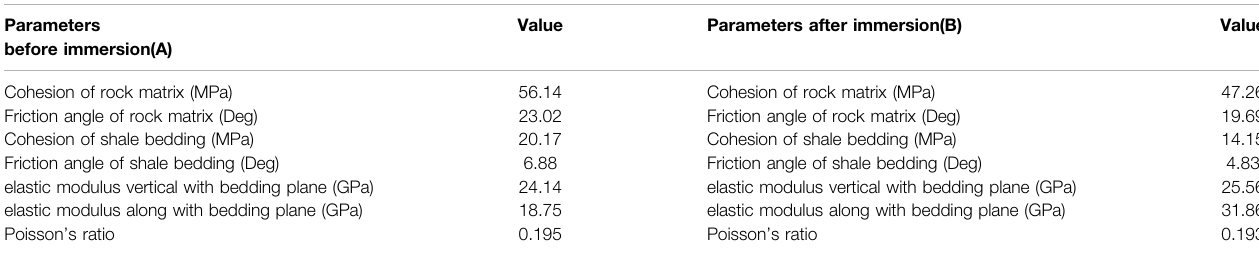
TABLE 4 | Mechanical parameters of rock before and after immersion. Parameters before